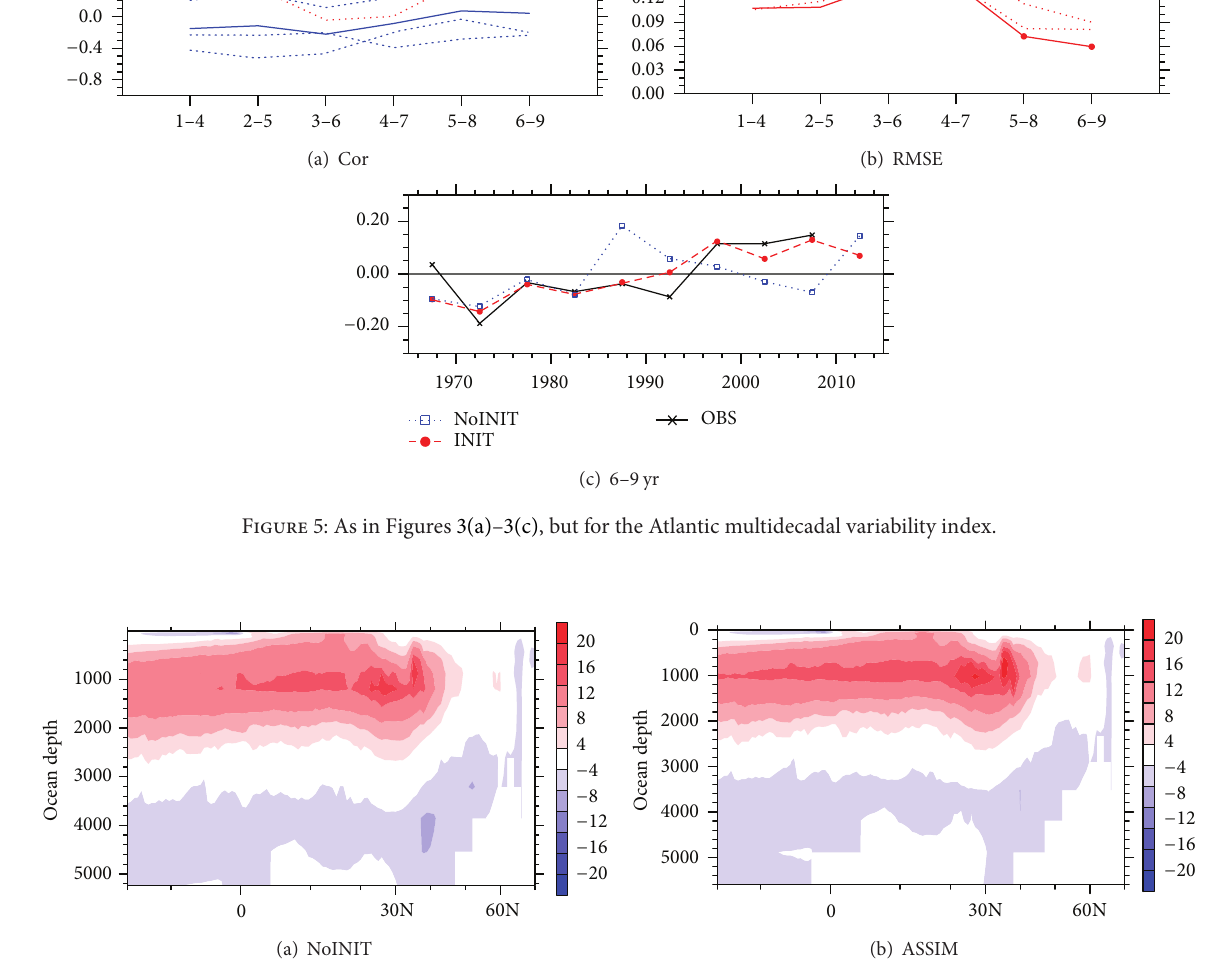
especially in the early prediction time. The negative